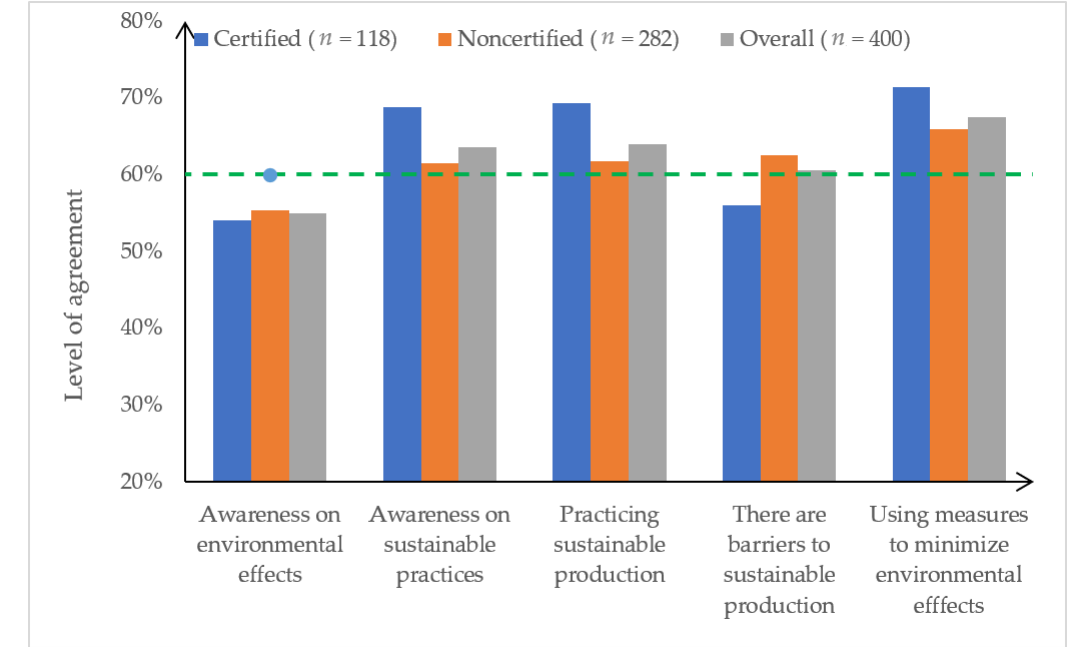
Figure 5. Level of agreement on various certification statements. Source: Coffee farmers’ household survey, 2021